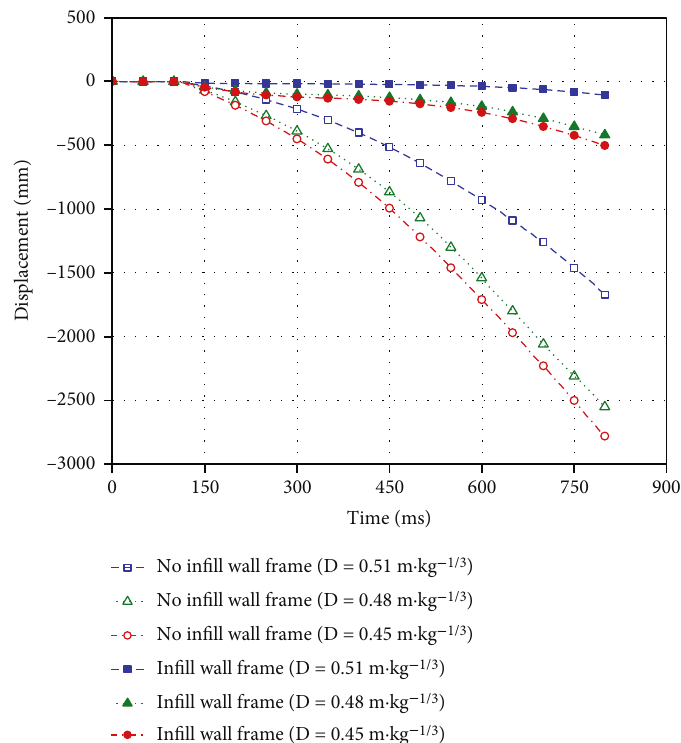
Figure 11: The z -directional displacement of the apex of the column on the third fl